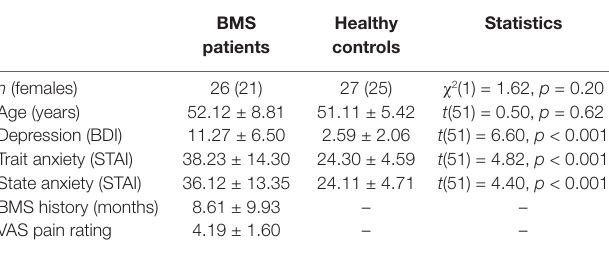
TABLE 1 | Demographic characteristics and clinical measures of participants ( M ±